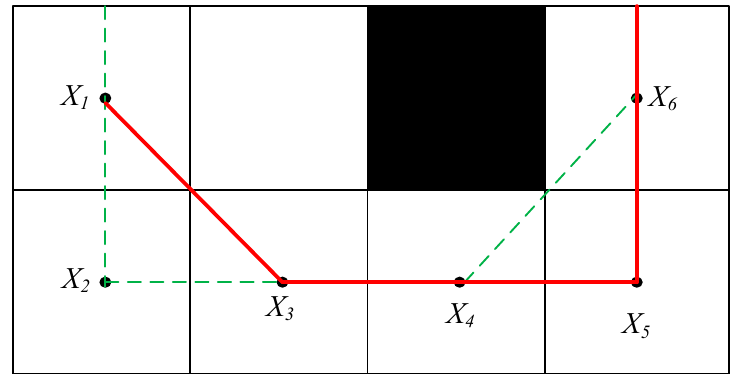
Figure 2. Secondary de-redundant path.